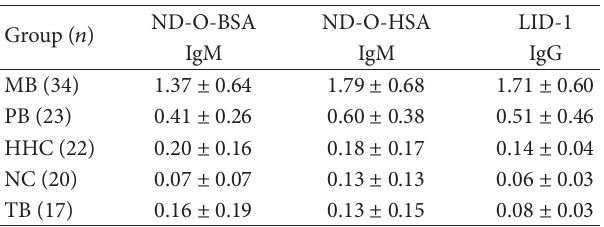
T 1: Comparison of antibody titers (mean and SD) of each